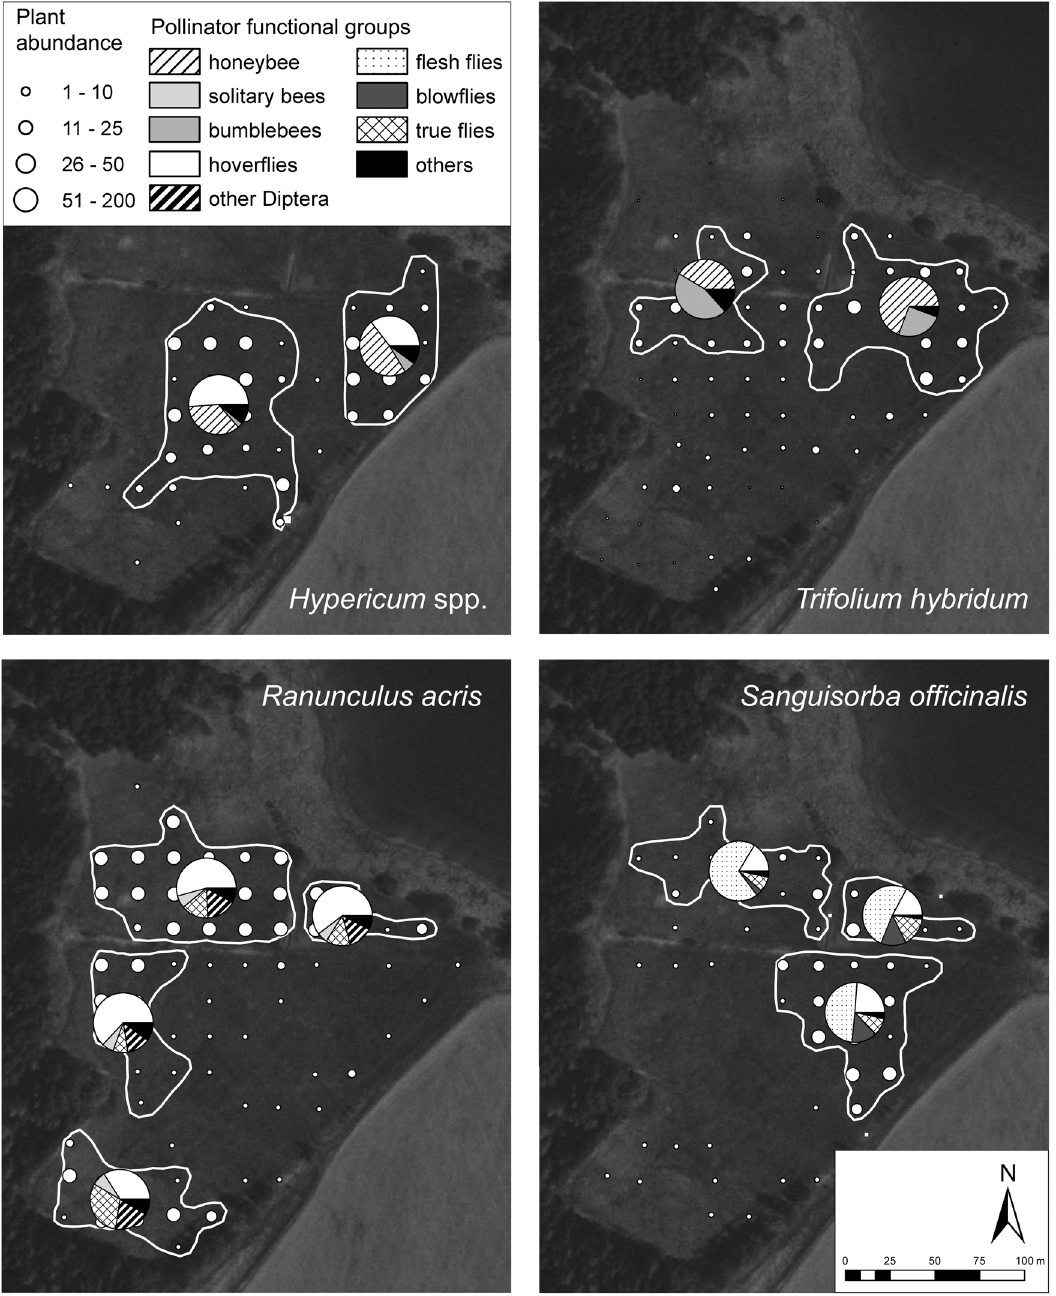
Figure 2. Maps of recorded pollinator spectra for different meadow sectors with more than 50 pollinators recorded for four of the focal plant species. Flowering stalk abundances depicted by size of the dots; please note the different, semi-quantitative scale for Trifolium hybridum (0–64 subplots occupied). Please note that in each case the category ‘‘others’’ comprises different pollinator groups (see Materials and Methods for explanation). For more detailed information on pollinator abundances and spectra please refer to Figs. S3, S4. Aerial photograph credit: Czech Office for Surveying, Mapping and Cadastre. doi:10.1371/journal.pone.0077361.g002 matrices met the x 2 -test assumptions. For S. officinalis , this did not suffice to meet the criterion, and therefore for this species the ‘‘other’’ pollinator functional group was not included in the analysis. All computations were done in the R 2.12.0 statistical